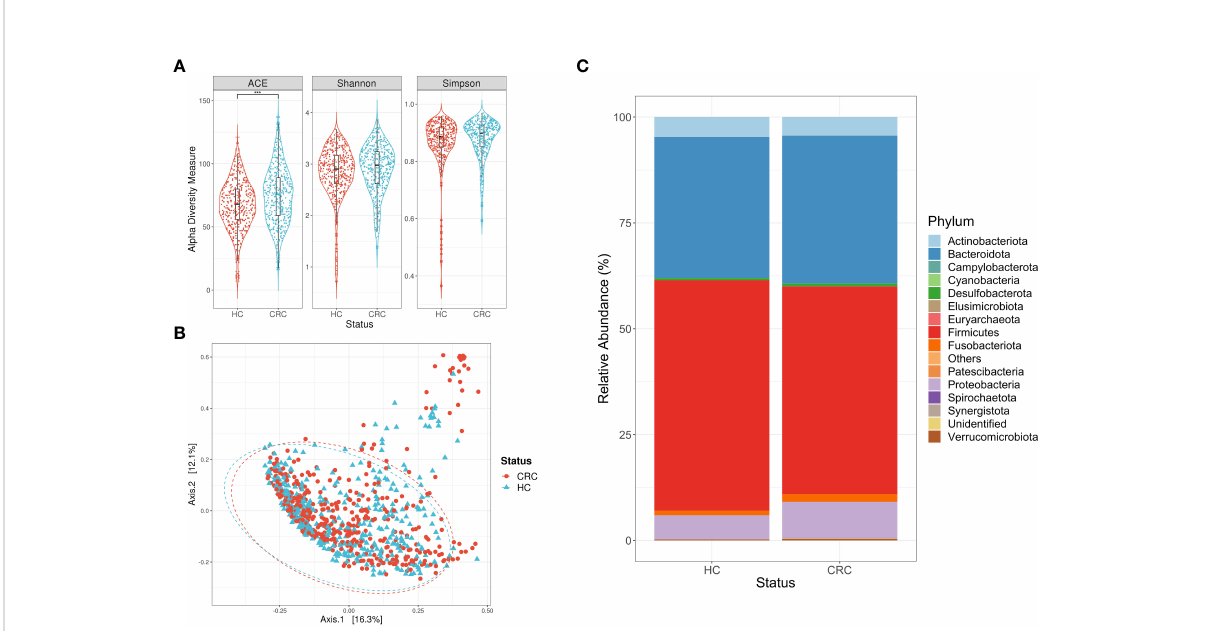
FIGURE 1 Descriptive analysis for the consolidation of studies focused on colorectal cancer (CRC). (A) Alpha diversity measures calculated for the ASVs of subjects with CRC and their respective controls (HC). Statistical differences were evaluated with a T test (***p-value <0.001). (B) Principal Coordinate Analysis (PCoA) for the ASVs of subjects with CRC and their respective controls (HC). Statistical differences of beta diversity were evaluated with the adonis test (r 2 = 0.037, p-value <0.001). (C) Relative abundance of the phyla for each of the study groups, being Firmicutes, Bacteroidota, and Proteobacteria the predominant